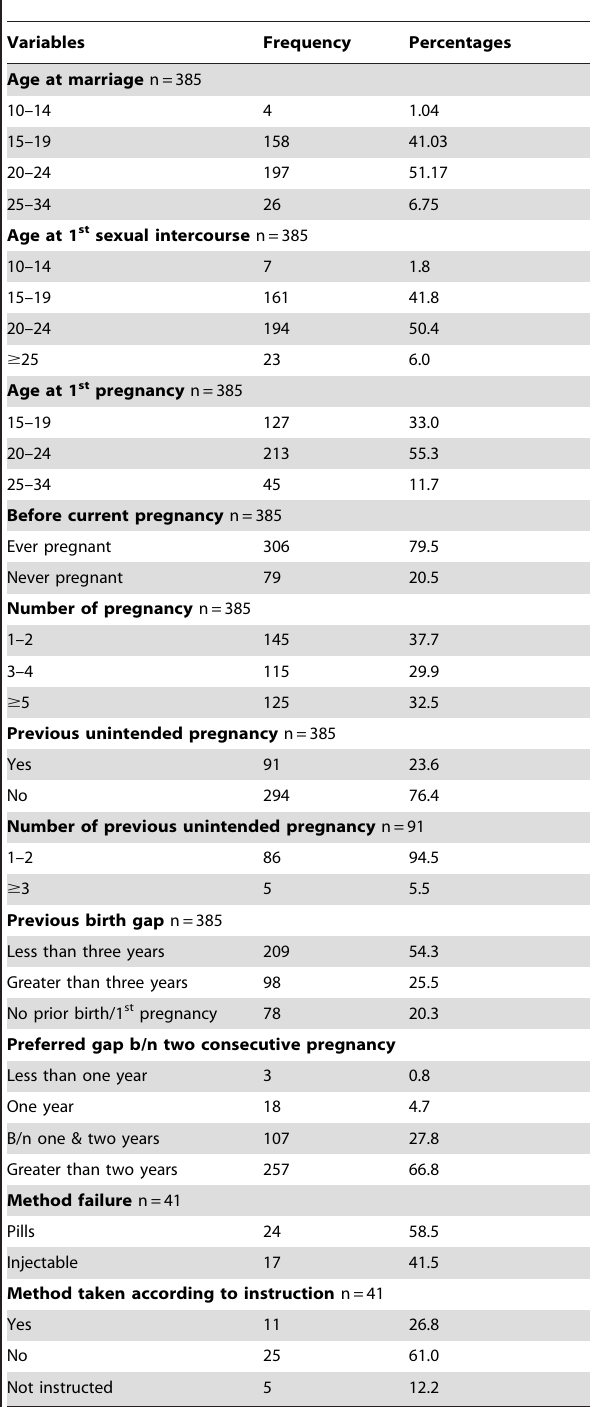
Table 2. Reproductive History of Pregnant Married Women in Hossana Town, SNNP, April